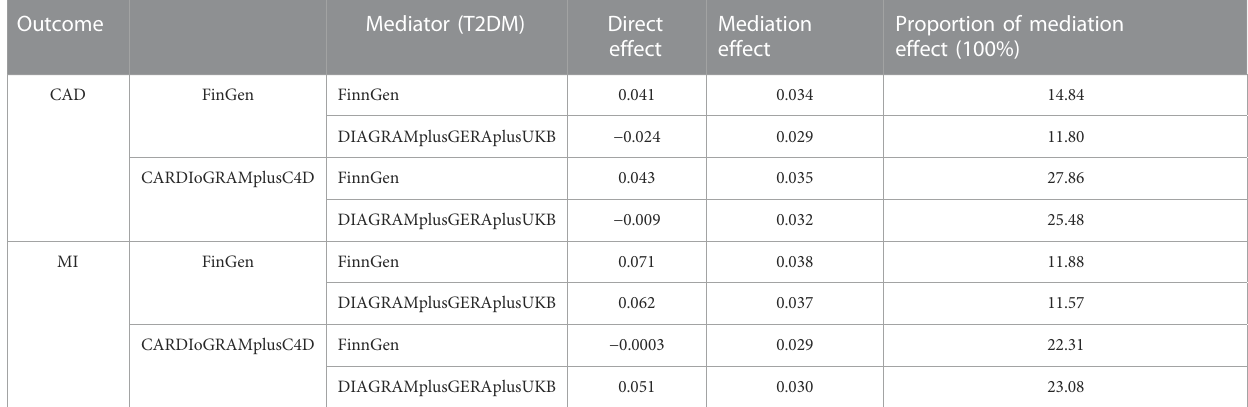
TABLE 5 Mediation analysis of the mediation effect between RuminococcaceaeUCG010 and CAD/MI via T2DM.